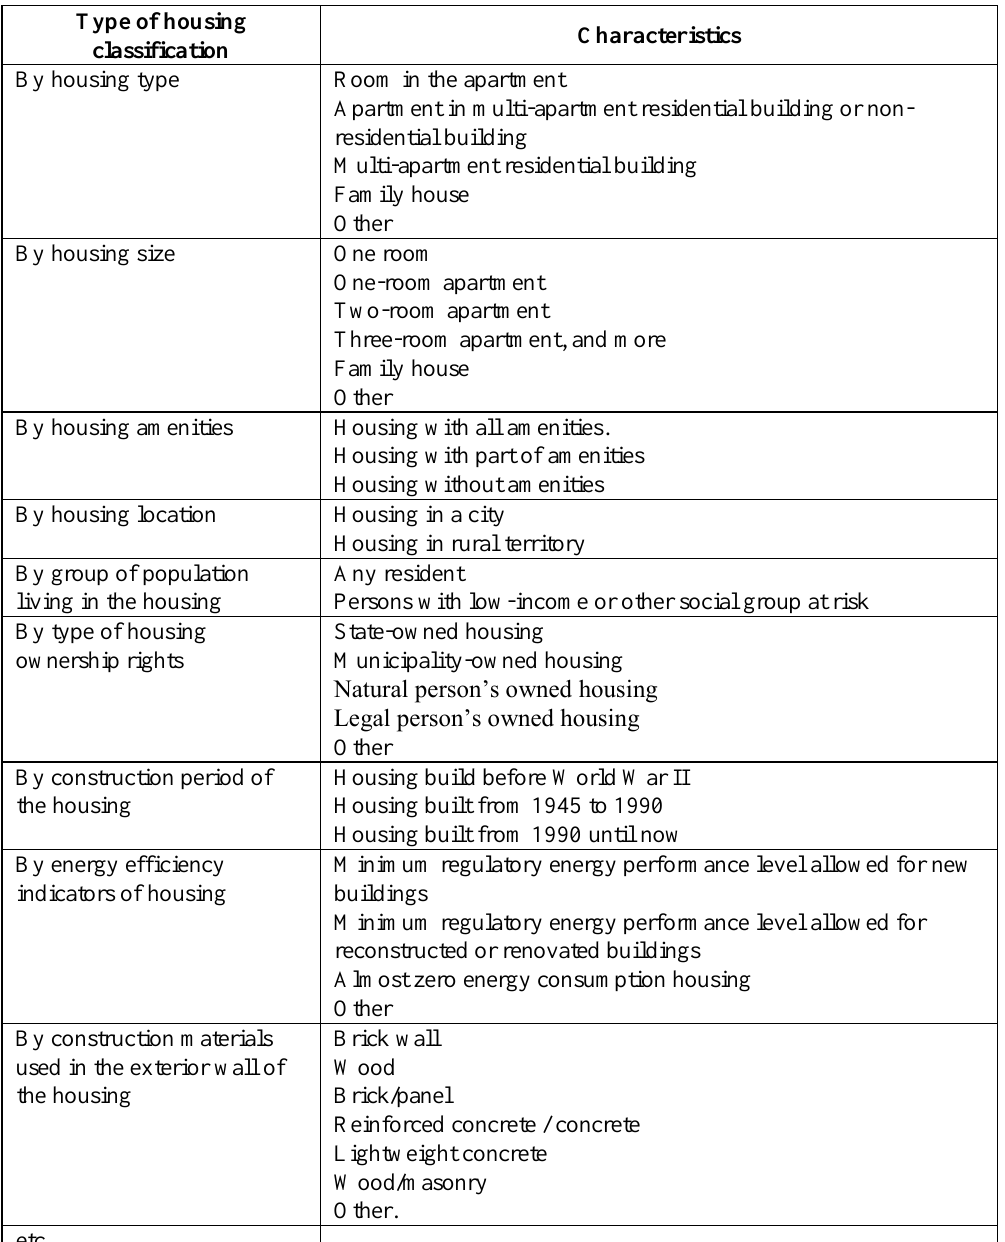
Table 1 . Housing